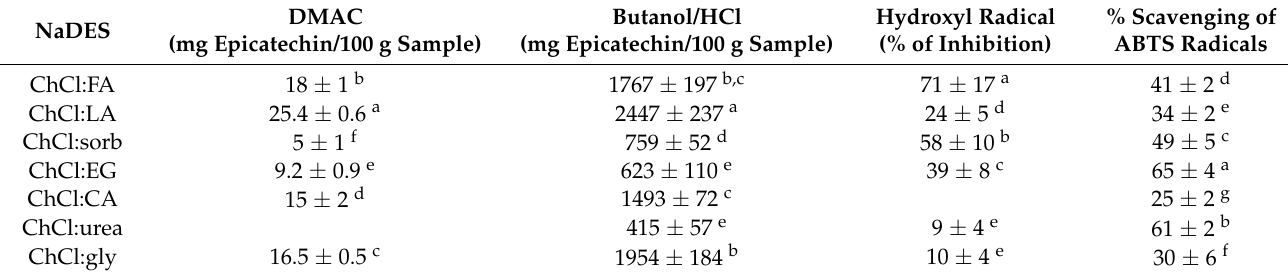
Table 2. Total PA content (DMAC and butanol/HCl assays) and total antioxidant capacity (ABTS radical scavenging activity and capacity to inhibit the formation of hydroxyl radical assays), obtained from the extraction residue of mangosteen peel by UAE with different